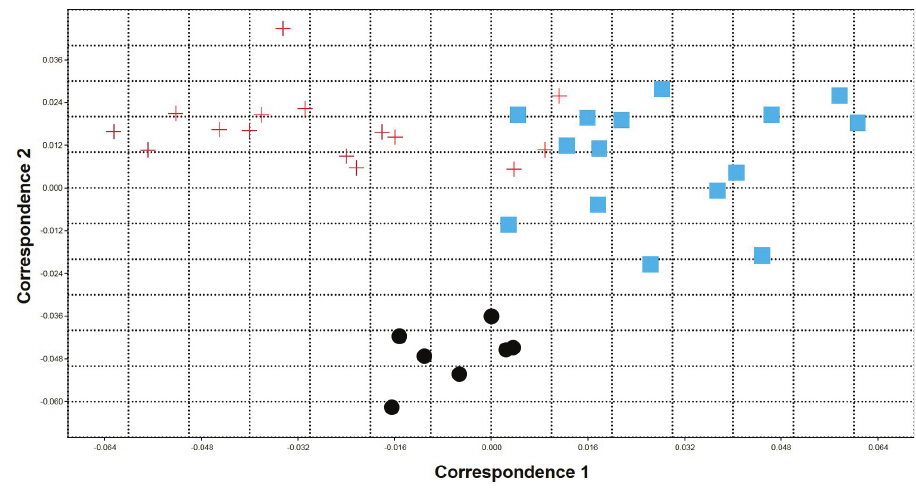
Figure 12. Correspondence analysis of meristic characters of the Capoeta razii sp. n. ( + ) C. fusca (•) and C. capoeta (  )